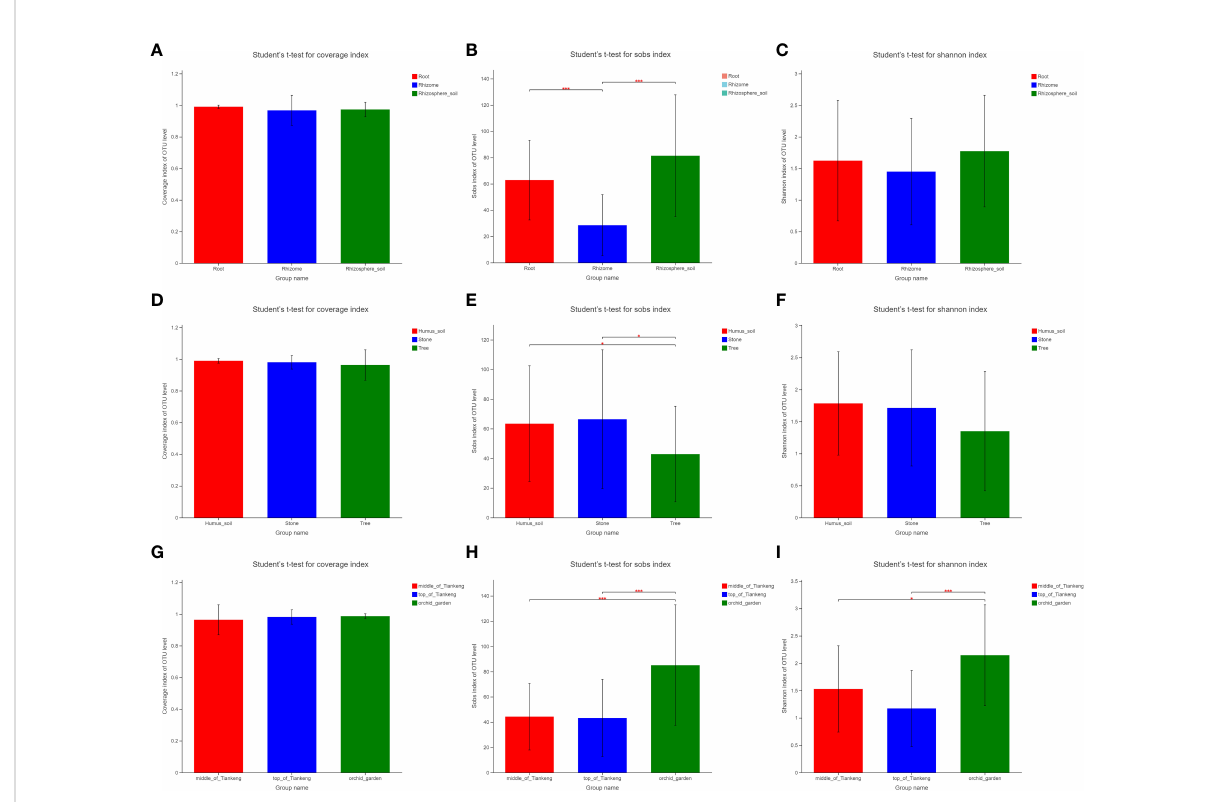
FIGURE 5 Wilxocon rank sum test of Alpha index difference between groups. The signi fi cance of the difference between the two groups is expressed as: 0.01 <p ≤ 0.05 marked for *, P ≤ 0.001 marked for ***. The abscissa is the grouping name, and the ordinate is the index average of each group. (A-C) : root, rhizome and rhizosphere soil groups; (D – F) : different habitat groups; (G – I) : different altitude